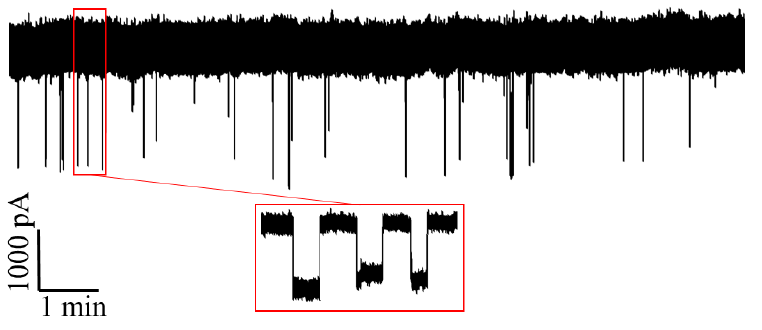
Figure 2. IgG nanopore detection signal.